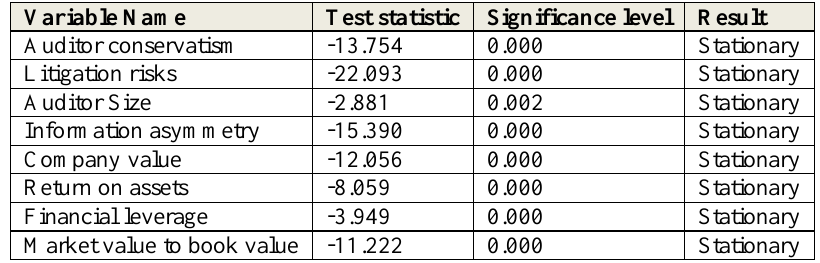
Table 2. Stationary test (Harris) for all variables of the